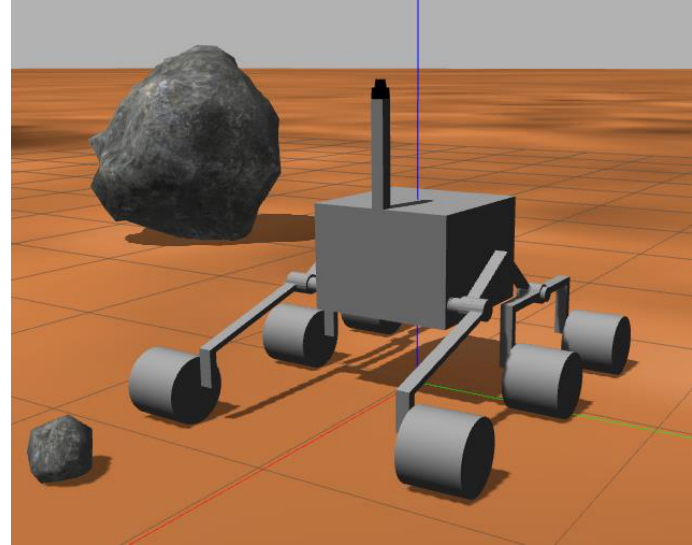
Figure 2. A 3D model of the rover in a Martian-like environment.